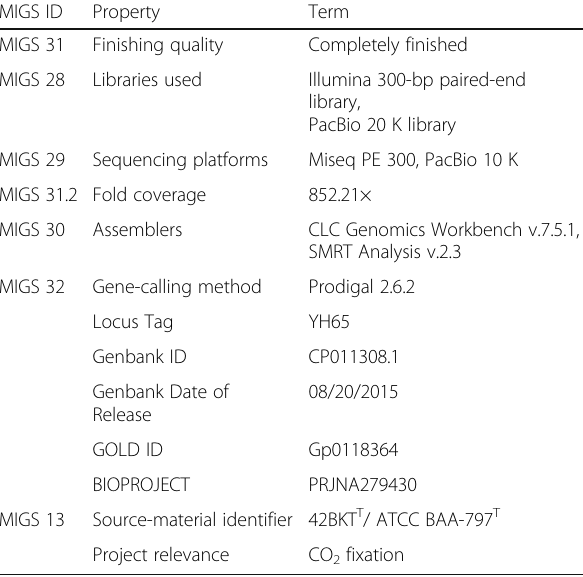
Table 2 Project information Table 1 Classification and general features of Sulfurovum